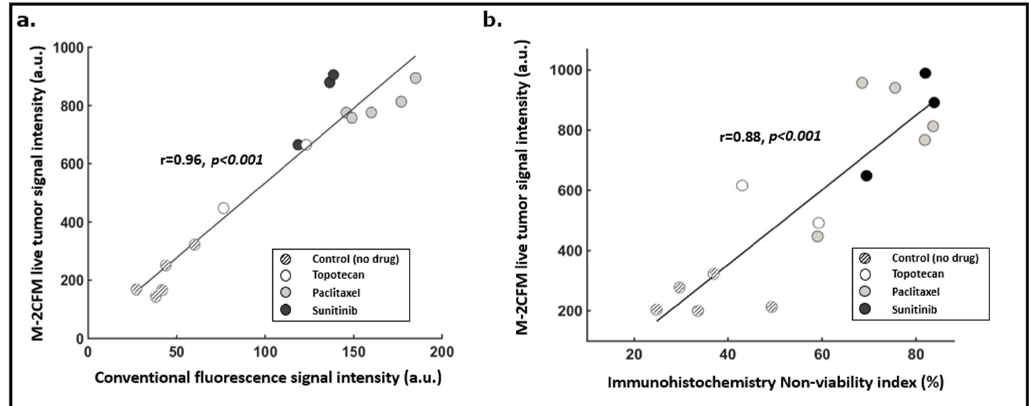
Figure 7. ( a ) Correlation between the M-2CFM live tumor fluorescence imaging and conventional benchtop fluorescence imaging of corresponding tumor sections (r = 0.96, p < 0.001). ( b ) Correlation between the M-2CFM live tumor fluorescence imaging signal intensity and a non-viability index calculated from gold standard immunohistochemistry hematoxylin and eosin (H&E) stained sections (r = 0.88, p < 0.001). n = 15 replicate drug sites from five tumors were used for this correla- tion.